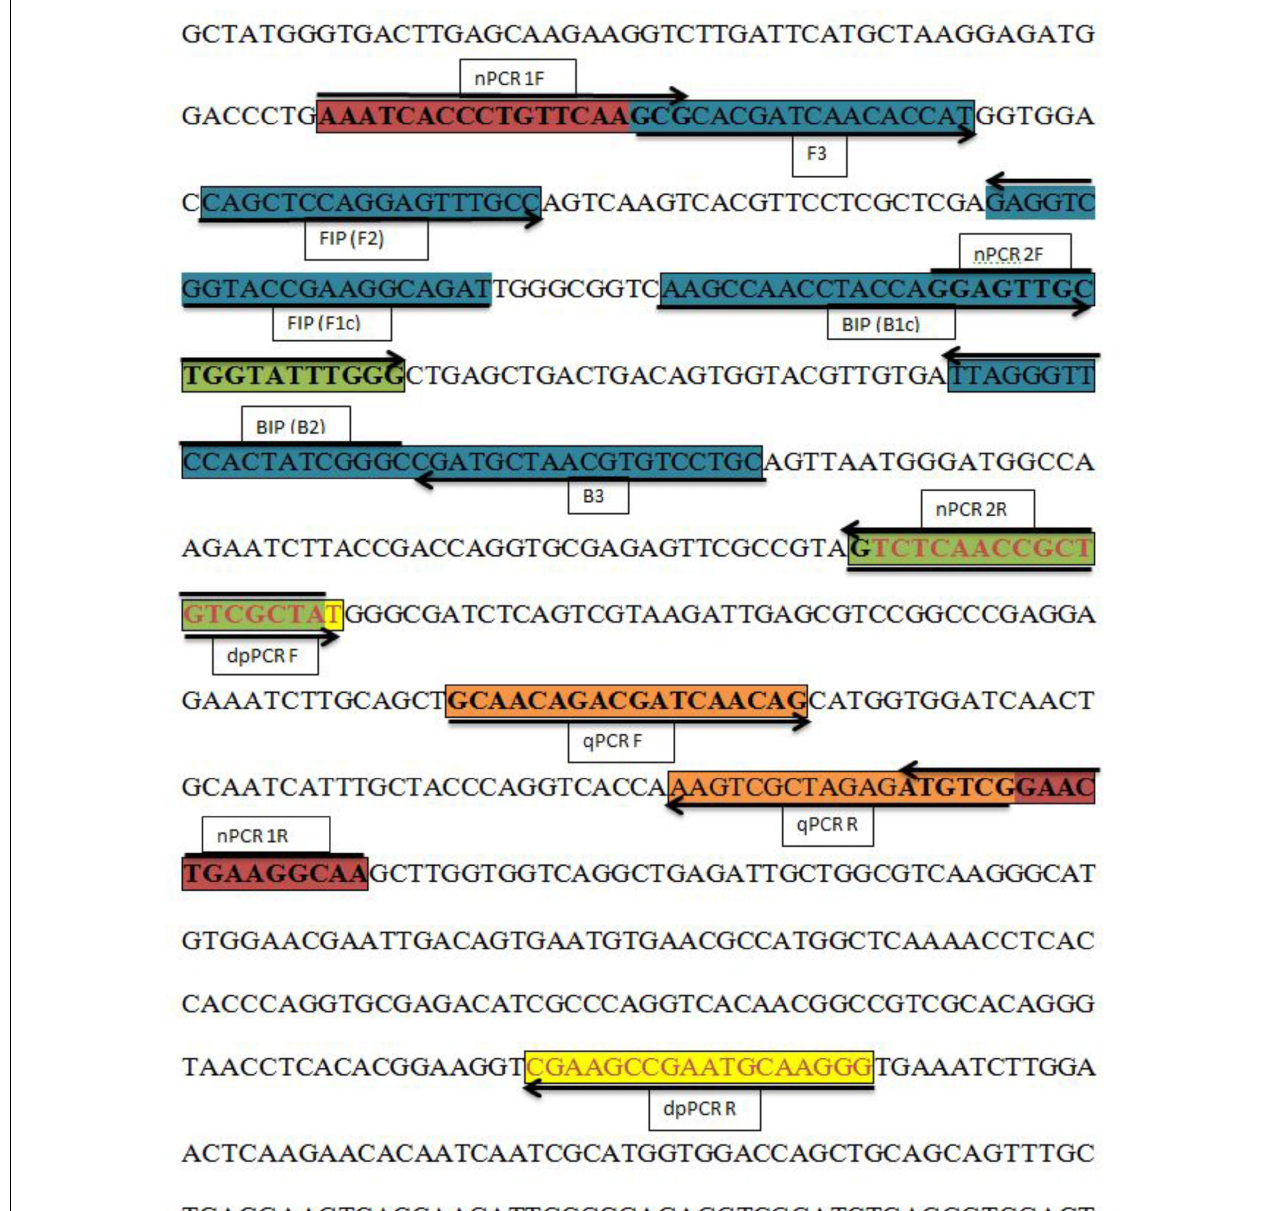
FIGURE 1 | Sequence and location of the A. solani histidine kinase gene (HK1) used to design different polymerase chain reactions (PCRs) and loop-mediated isothermal amplification (LAMP) primers. Primer locations for different PCRs [Real-time PCR (qPCR F, qPCR R); Nested PCR (nPCR1 F, nPCR1 R, nPCR2 F, and nPCR2 R)], Duplex PCR (dpPCR F, dpPCR R), and LAMP assays [F3, B3, FIP (F1c-F2), BIP (B1c-B2)]. FIP is a hybrid primer consisting of the F1c and F2 sequences; BIP is a hybrid primer consisting of the B1c and B2 sequences. Primer sequence sites are colored and marked. Arrows indicate the extension